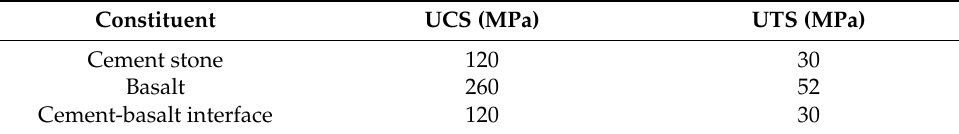
Table 3. Strength parameters for concrete constituents and matrix-aggregate interface. Constituent UCS (MPa) UTS (MPa) Cement stone 120 Basalt 260 Cement-basalt interface